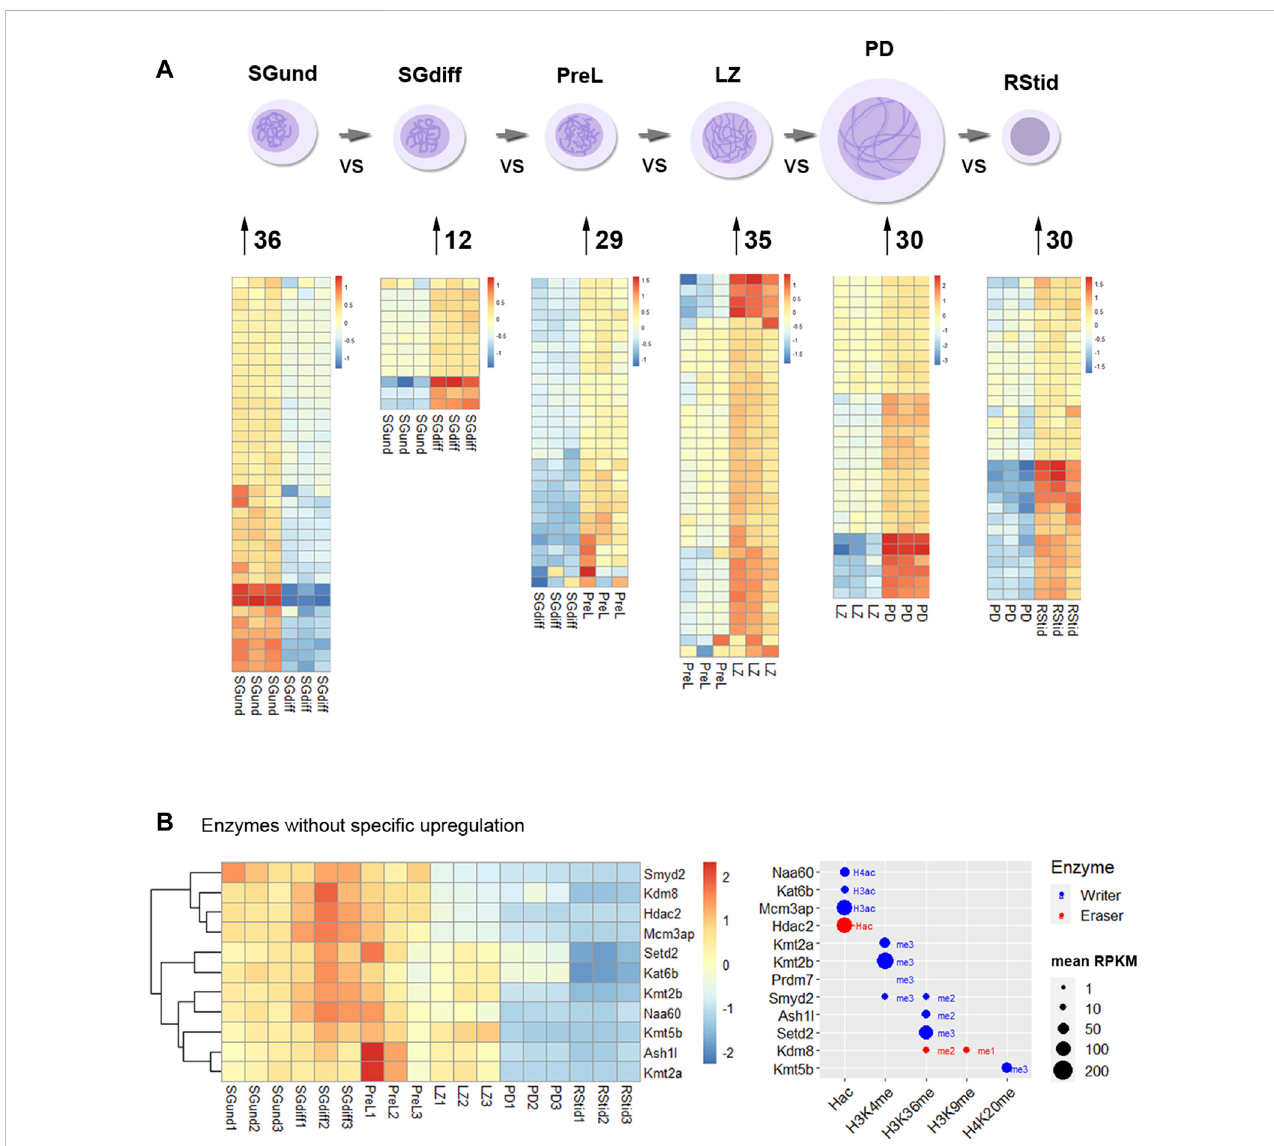
FIGURE 3 Histone K acetylation and methylation epigenetic enzymes expression during spermatogenesis. (A) Number of upregulated epigenetic enzymes and heatmap showing z-score values for each germ cell stage. Differential gene expression analysis was conducted with DESeq2 with LRT test and contrasts on consecutivepopulationsacrossdifferentiation(SGdiffvs.SGund,PreLvs.SGdiff,LZvs.PreL,PDvs.LZandRStidvs.PD).Upregulatedgeneswereselectedwith padj < .05 and log2FC > .5. (B) Left: Heatmap showing epigenetic enzymes without speci fi c upregulation at any germ cell stage across spermatogenesis. Right: Bubble chart showing enzymes mean RPKM values from SGund to PD populations. Blue dots: writers, red dots: erasers. SGund: spermatogonia Kit-, SGdiff: spermatogonia Kit+, PreL: pre-leptotene spermatocytes, LZ: leptotene/zygotene spermatocytes, PD:pachytene/diplotene spermatocytes, RStid: round spermatid. The H2/3/4ac reference indicates the histone target reported for each lysine acetylation writer. Hac indicates that lysine acetylation eraser was reported to erase acetylation on all histones